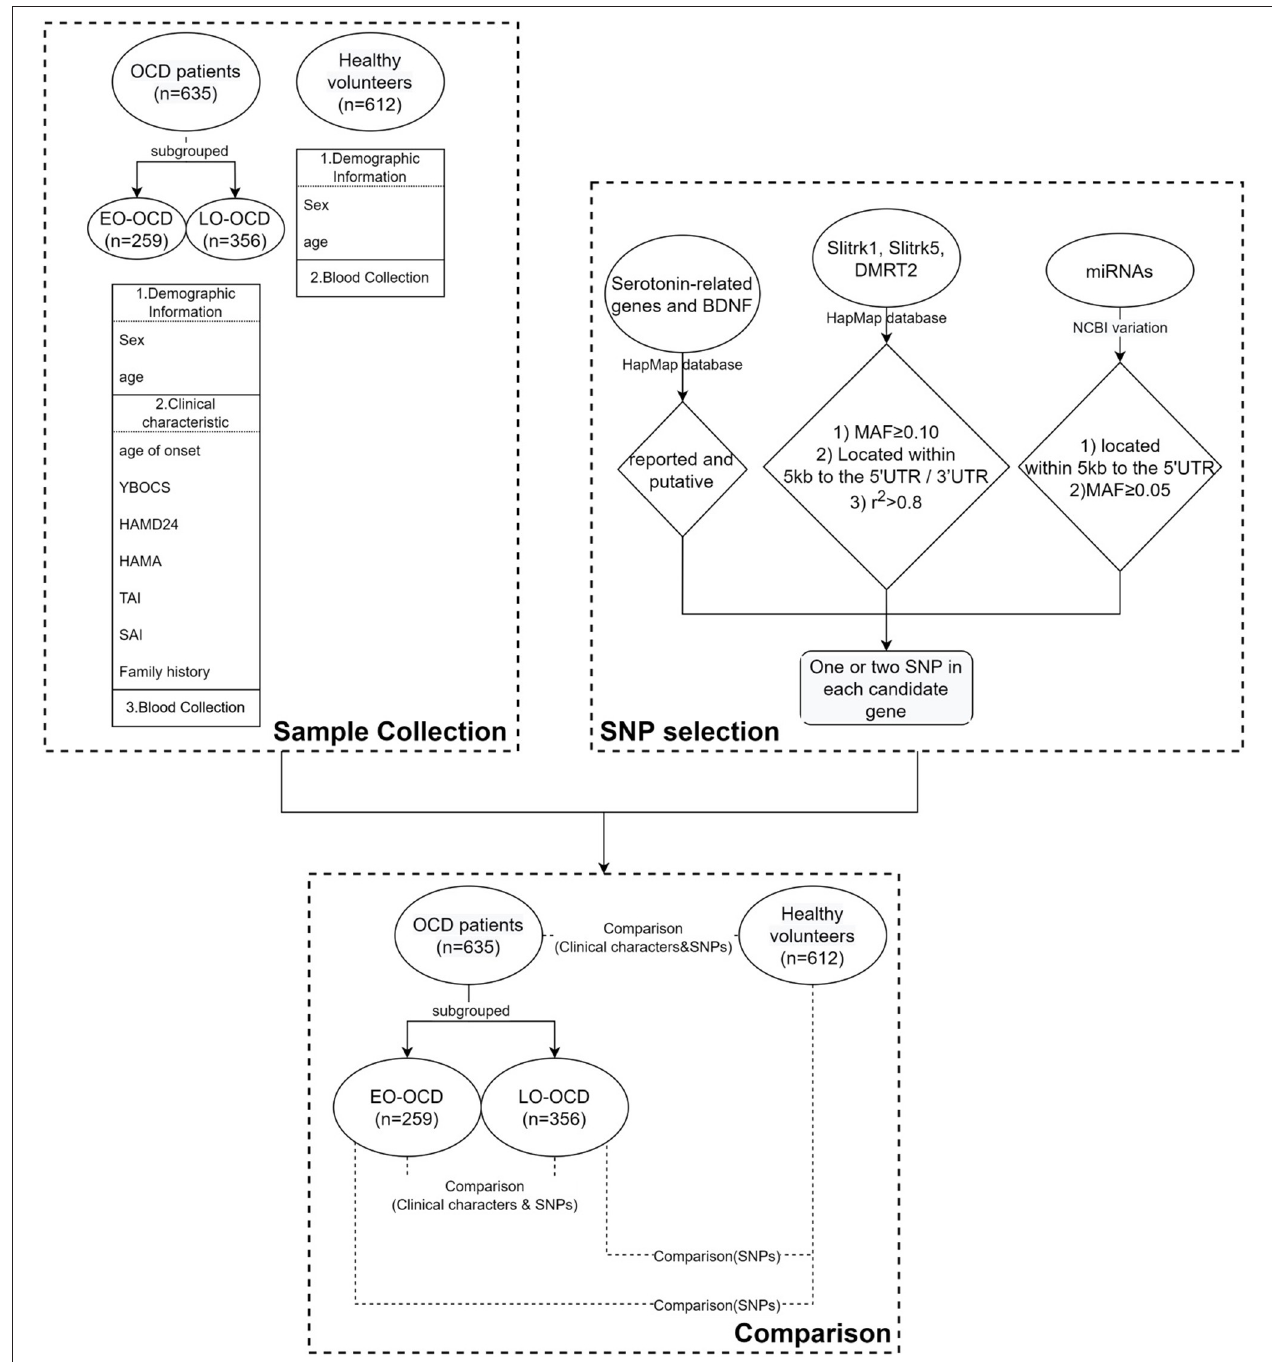
FIGURE 1 | The flowchart of our work.